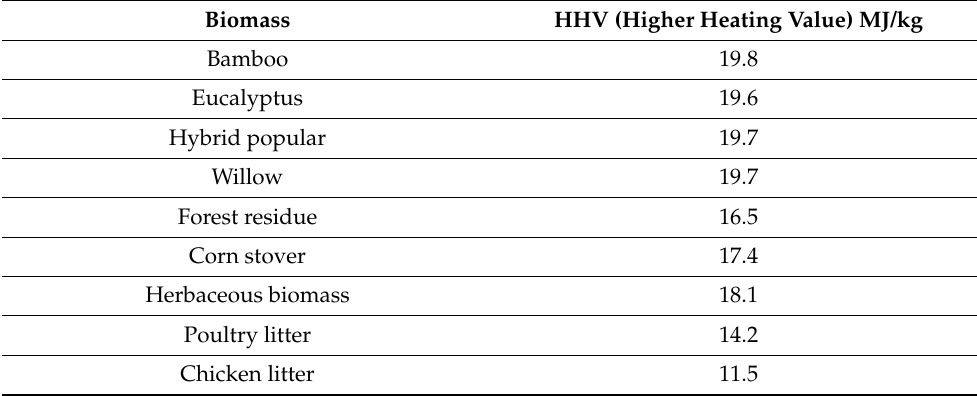
Table 4. The calorific value of dry bamboo and other